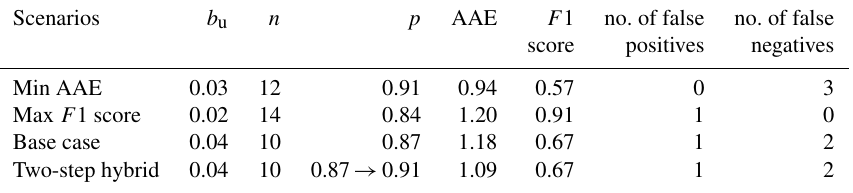
Table 1. Scenario examples of three parameters. Scenarios b u n AAE Min AAE